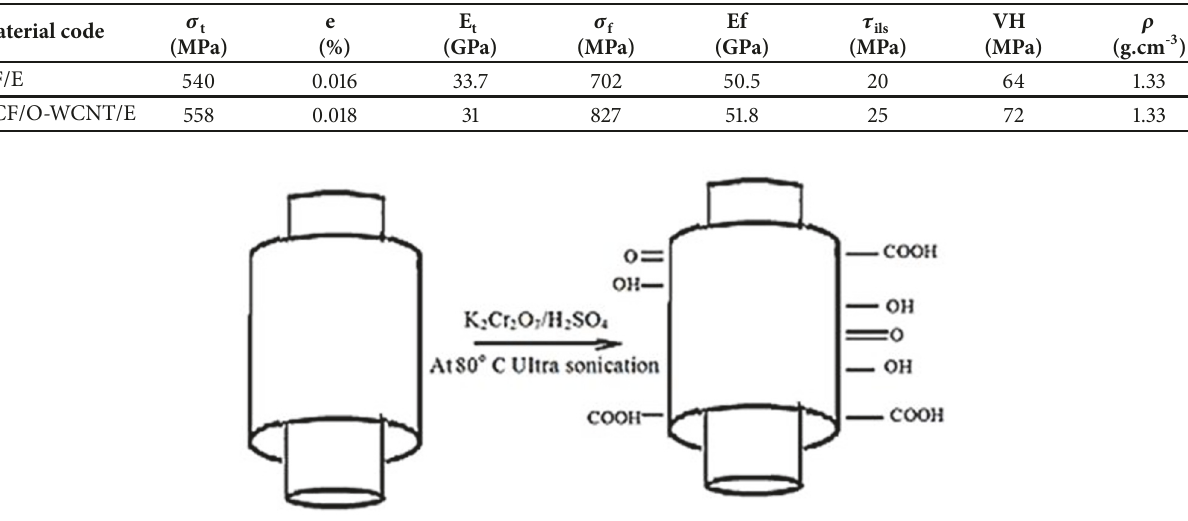
Table 1: Mechanical properties of CF/E and CCF/O-MWCNT/E composites.